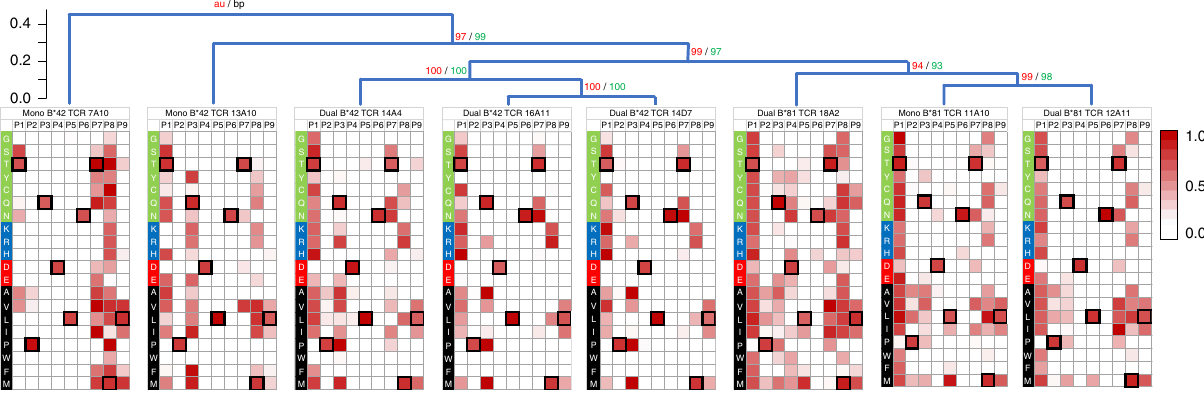
Fig. 5 Functional clustering of TCR clones based on TL9 variant recognition pro fi les. TCR recognition of TL9 variants was assessed by pulsing target cells expressing the donor HLA (B*81:01 or B*42:01) with a panel of 180 peptides encompassing all single amino acid substitutions at epitope positions 1 through 9 prior to co-culture with Jurkat T cells expressing the TCR of interest. TCR-dependent NFAT signaling was quanti fi ed by luminescence. Values were normalized to the mean signal obtained for consensus TL9 (set to 1.0), which was tested nine times in each experiment. Results are displayed as heatmaps, where the warmer color re fl ects higher relative luminescence values indicative of better TCR recognition. Peptide positions are shown at the top of each heatmap; amino acid substitutions on the consensus TL9 backbone are shown on the left-hand side. Amino acids are grouped according to chemical properties: polar residues (G, S, T, Y, C, Q, N) are highlighted in green; basic residues (K, R, H) are blue; acidic residues (D, E) are red; and hydrophobic residues (A, V, L, I, P, W, F, M) are black. For reference, the consensus TL9 residue at each position is indicated using a box. TCR were grouped according to their functional pro fi les by hierarchical clustering using correlation distances and single linkage methods (5000 iterations) implemented in pvclust (http://stat.sys.i.kyoto-u.ac.jp/ prog/pvclust/). The dendrogram (top) displays approximately unbiased (au) p -values in red text and bootstrap probability (bp) values in green text. The three B*81:01-derived TCR clustered with bp values of 93 or higher. The three public dual-reactive B*42:01- derived TCR clustered with bp values of 100; and, notably, they grouped more closely with B*81:01 clones (bp value of 97), rather than